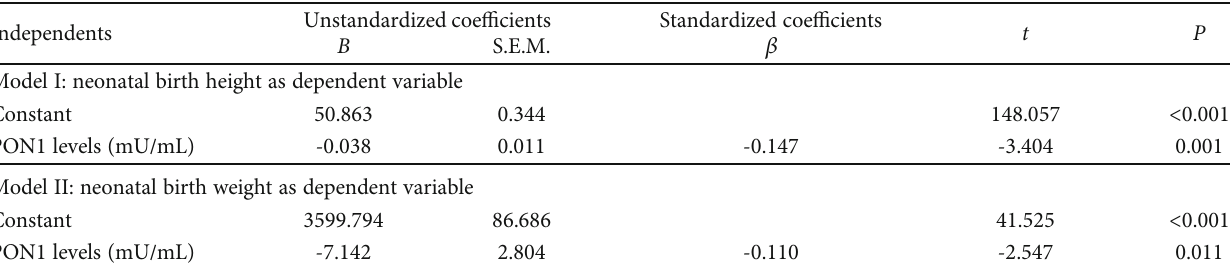
Table 6: Association of lactonase activities, level, and genetic polymorphisms of PON1 with the neonatal birth height and weight by multivariate regression analysis in the women with and without